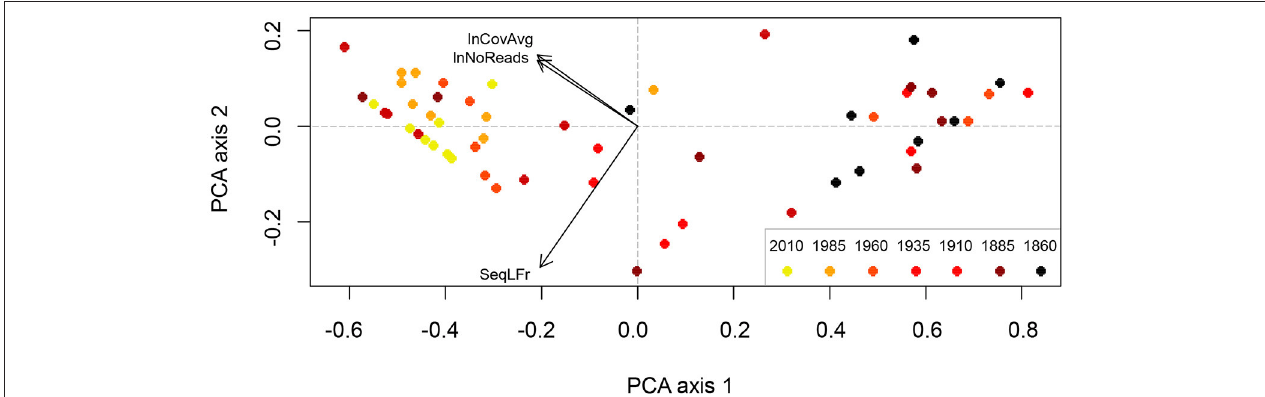
FIGURE 6 | PCA ordination (axes 1 and 2) of the three DNA-characteristics, relative recovered sequence length (SeqLFr), ln-transformed number of reads (lnNoReads) and ln-transformed mean read coverage (lnCovAvg) as recorded for the 56 lichen samples. The points represent samples with the time-period, in which they were collected, indicated by different colors (legend inserted lower right). The arrows indicate the direction of maximum increase of each of the three variables in the PCA ordination diagram. The axes are scaled in arbitrary units.